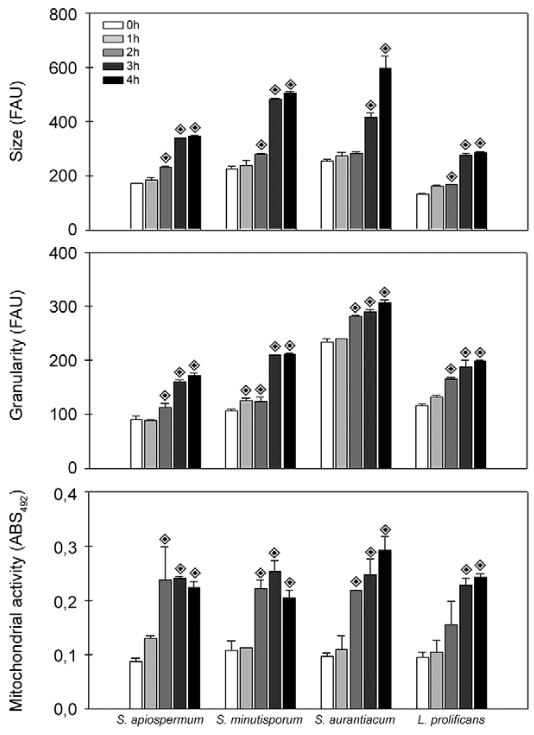
: morphological parameters and metabolic activity evaluated during the transformation from conidia to germinated conidia of Scedosporium apiospermum, S. minutisporum, S. aurantiacum and Lomentospora prolificans. In this set of experiments, conidial cells were incubated in Sabouraud medium at 37ºC in an atmosphere of 5% CO2 up to 4 h. After 0, 1, 2, 3 and 4 h, fungal cells were processed to estimate the size (forward scatter parameter) and granularity (side scatter parameter) by flow cytometry analysis and the results were expressed as fluorescence arbitrary units (FAU). In parallel, the mitochondrial activity was measured by monitoring the metabolic reduction of XTT at 492 nm using a microplate reader. The results are shown as the mean ± standard deviation of three independent experiments. p values were obtained comparing the dormant 0 h conidial cells to the other time-points in which the conidia were collected, and the diamond symbols indicate that p < 0.05 (Student’s t test).